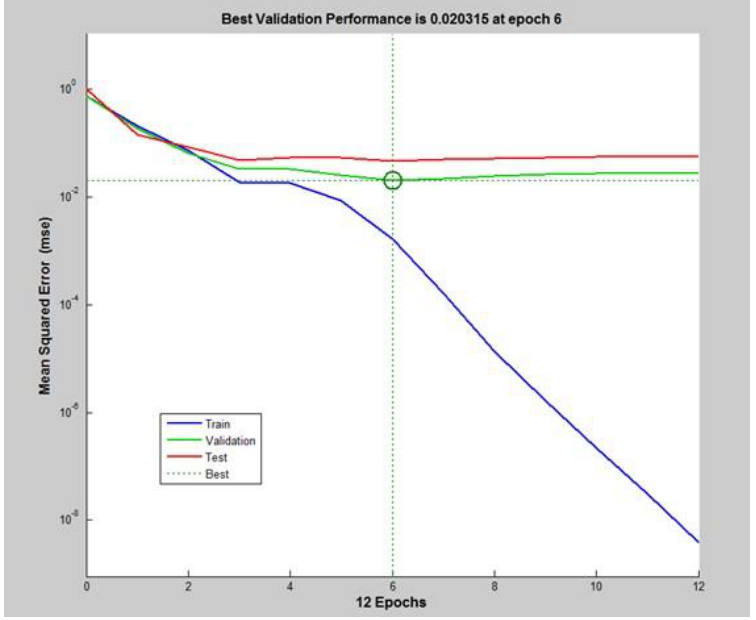
Figure 14. NN training, testing, and validation performance.